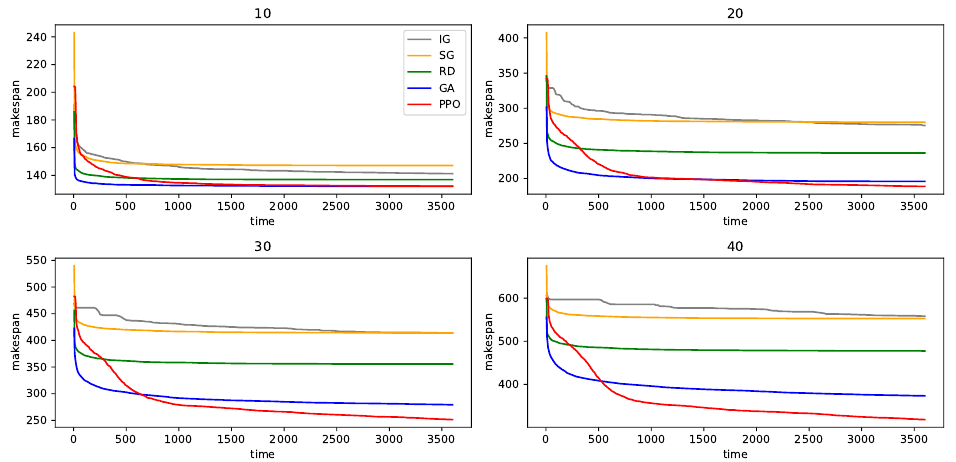
Figure A1. Minimum makespan until the indexed time for 100 problem instances of 5 robots and various number of tasks. The title of each graph is the number of tasks. The lines indicate the average of all samples for each